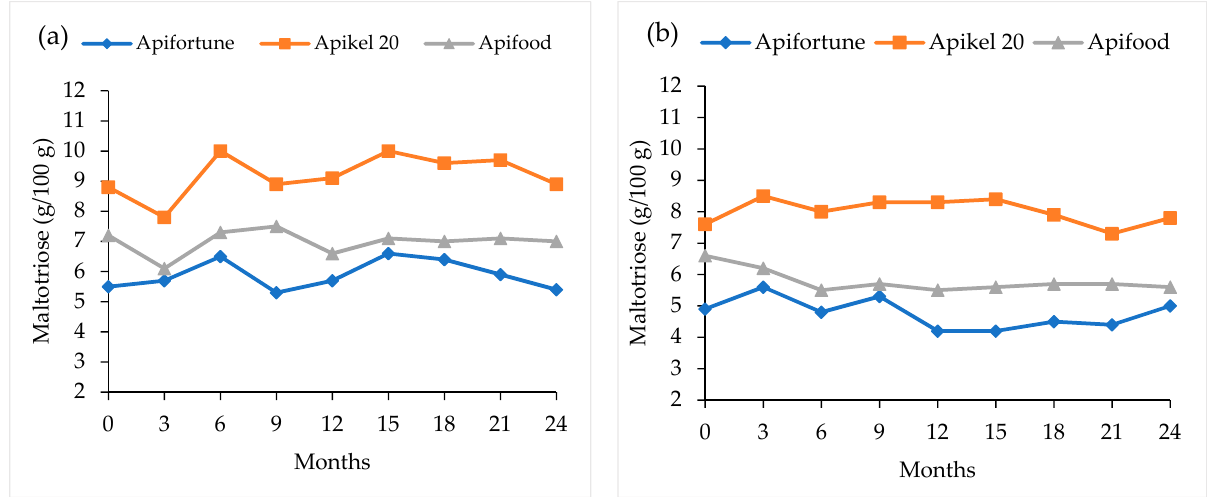
Figure 14. Changes of maltotriose content in syrups during storage at about 20 °C ( a ) from 2012 and ( b ) from 2013.